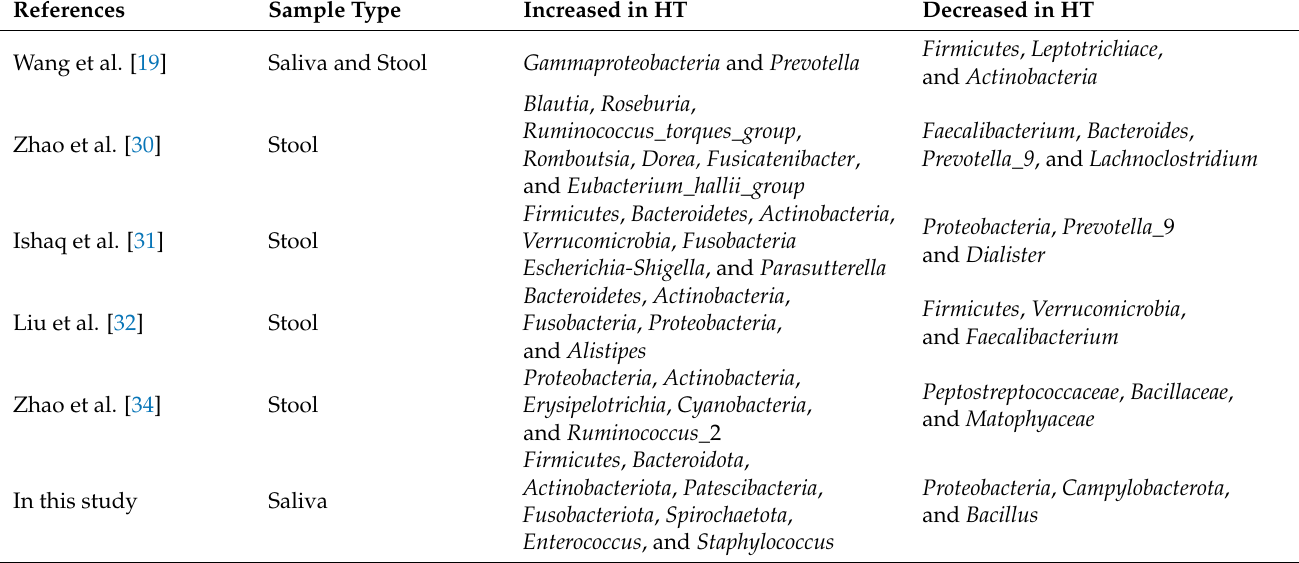
Table 3. Distribution of different microbiota reports on